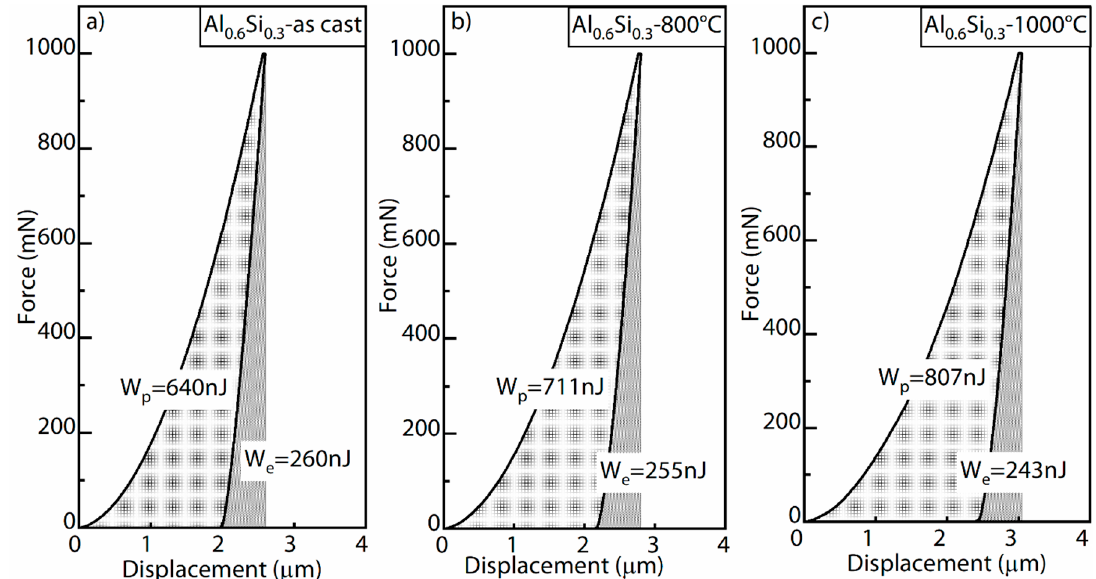
Figure 12. Force-displacement curves of Al 0.6 Si 0.3 : ( a ) as-cast ( b ) heat-treated at T = 800 °C and ( c ) heat-treated at T = 1000 °C.